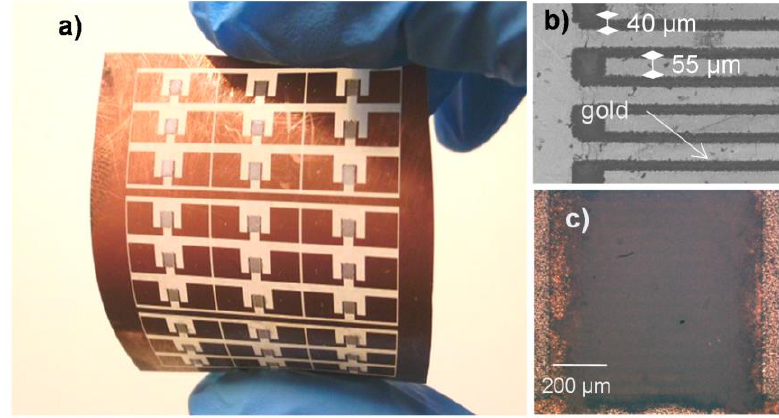
Figure 7. ( a ) Picture of 3 × 3 sensor matrices fabricated on PET substrate; ( b ) SEM image of the interdigitated electrodes; ( c ) optical image of the humidity sensors.